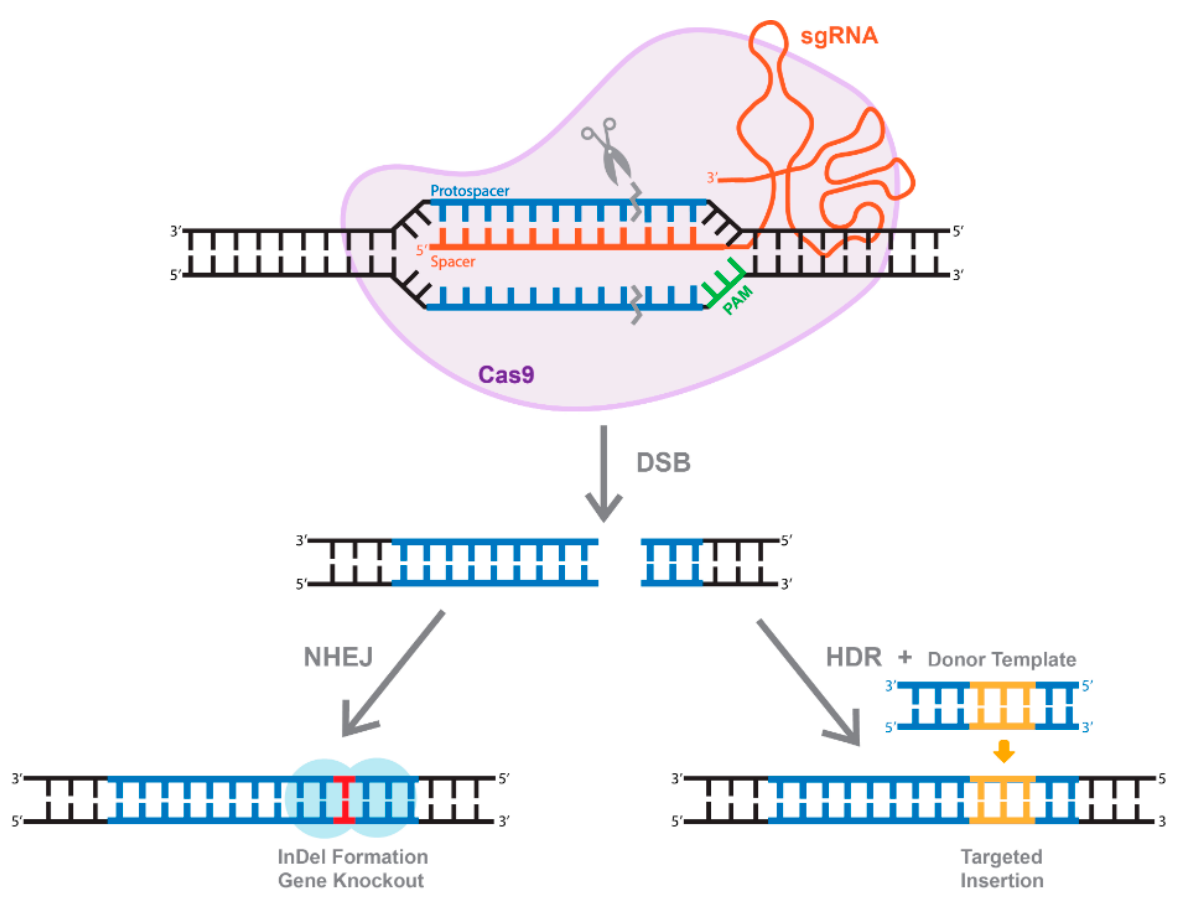
Figure 4. The overview of CRISPR/Cas system. Active Cas9 enzyme introduces a double-stranded break (DBS). The cell repairs through two methods, one of which is through non-homologous end joining (NHEJ) that create InDels. Alternatively, of a dsDNA donor template is provided, the DSB is repaired through homologous recombination (HDR), resulting in a targeted insertion.